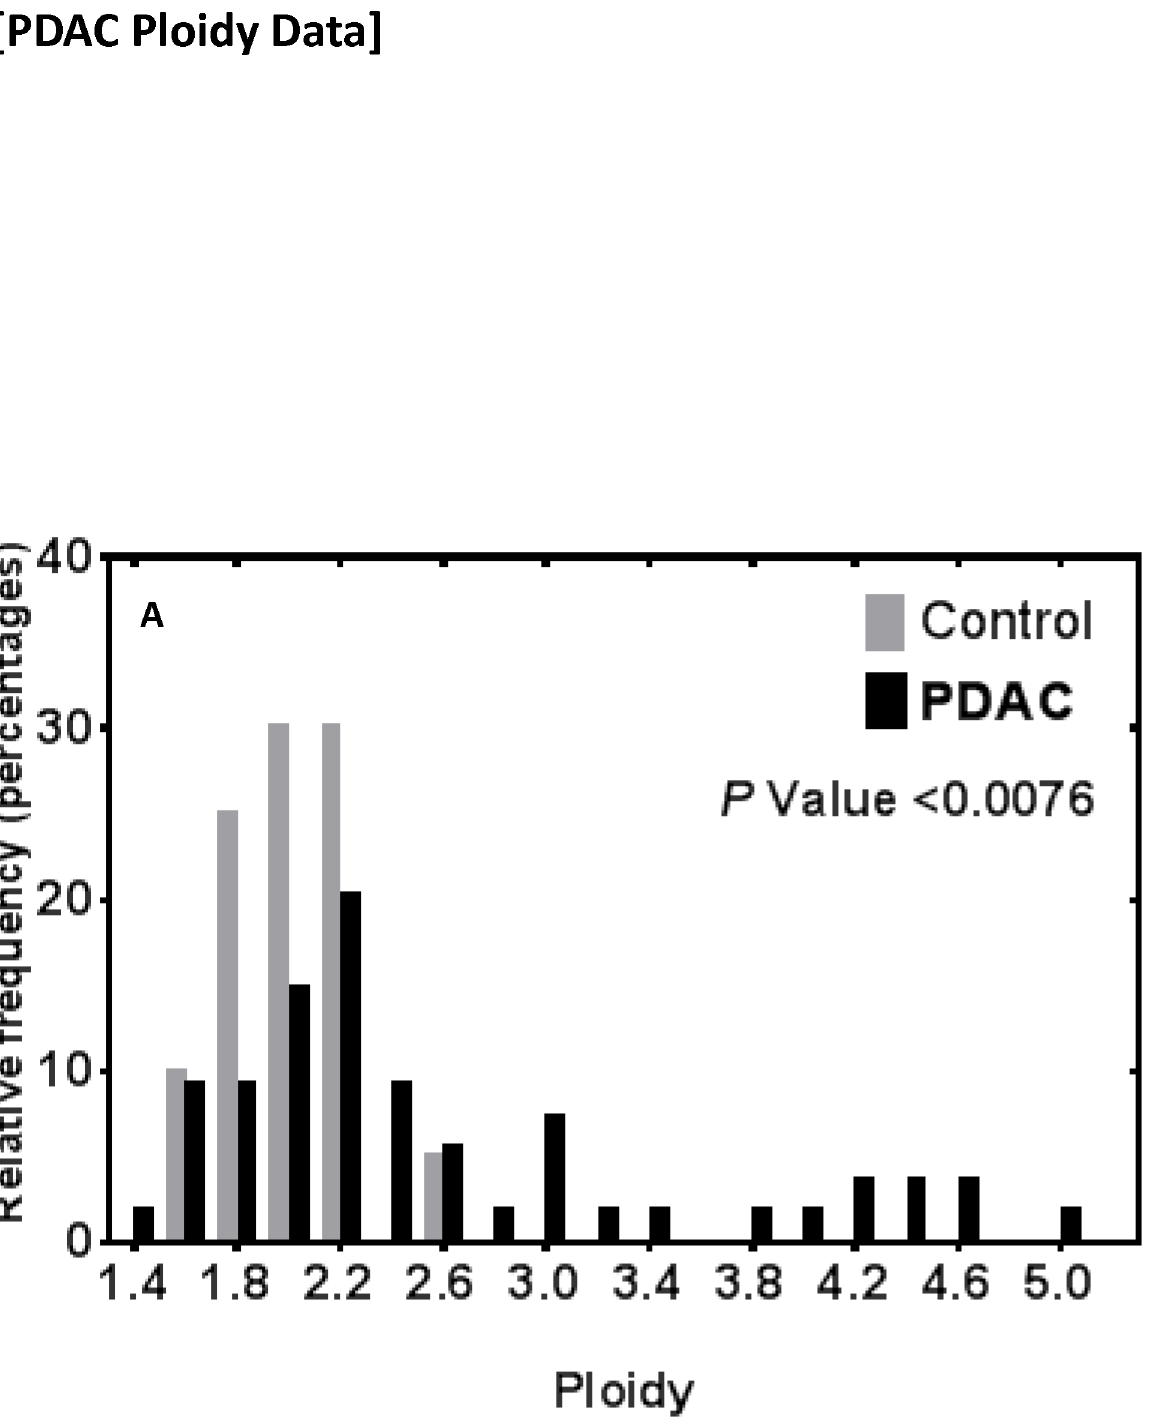
Fig 5. Ploidy analysis of dual-staining MTFs in PDACs. DNA content analysisof dual-stainingcells was performed as describedin PDACs in archival FFPE tissues. DNA content was also analyzedin adjacent “normal” pancreas (gray bars). Populationsof MTFs from 2 patients, showedcells with DNA distribution peaks correspondingto “para-diploid” but with many aneuploidycells distributed throughoutthe range, including some with DNA contents rangingup to 5n (black bars).